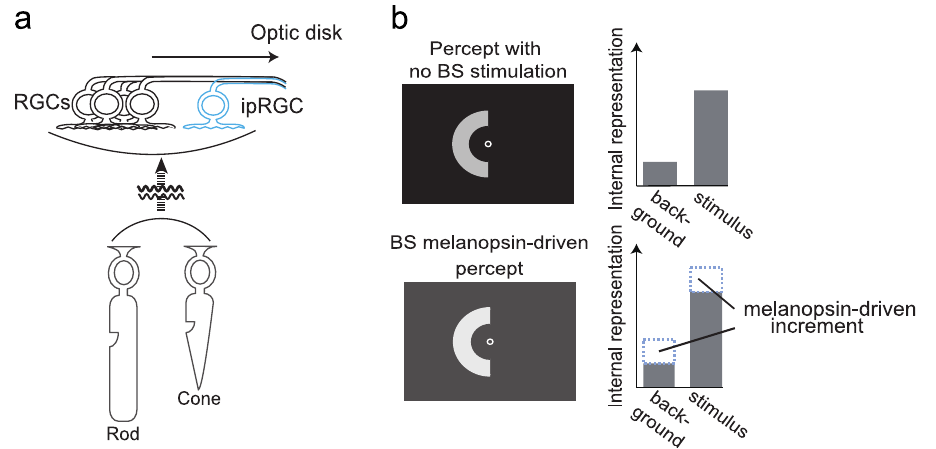
Figure 6. Proposed mechanism of the darkening effect. ( a ) Schematic view of ipRGCs in the retina. The axons of conventional RGCs and ipRGCs converge into the optic disk. Each ipRGC contains melanopsin within its soma and axon. ( b ) Schematic of the proposed mechanism for the BS illumination-mediated darkening effect of a remote stimulus. Because the luminances of both the stimulus and its background are interpreted as greater, the ratio of the interpreted luminance of the stimulus to that of its background becomes